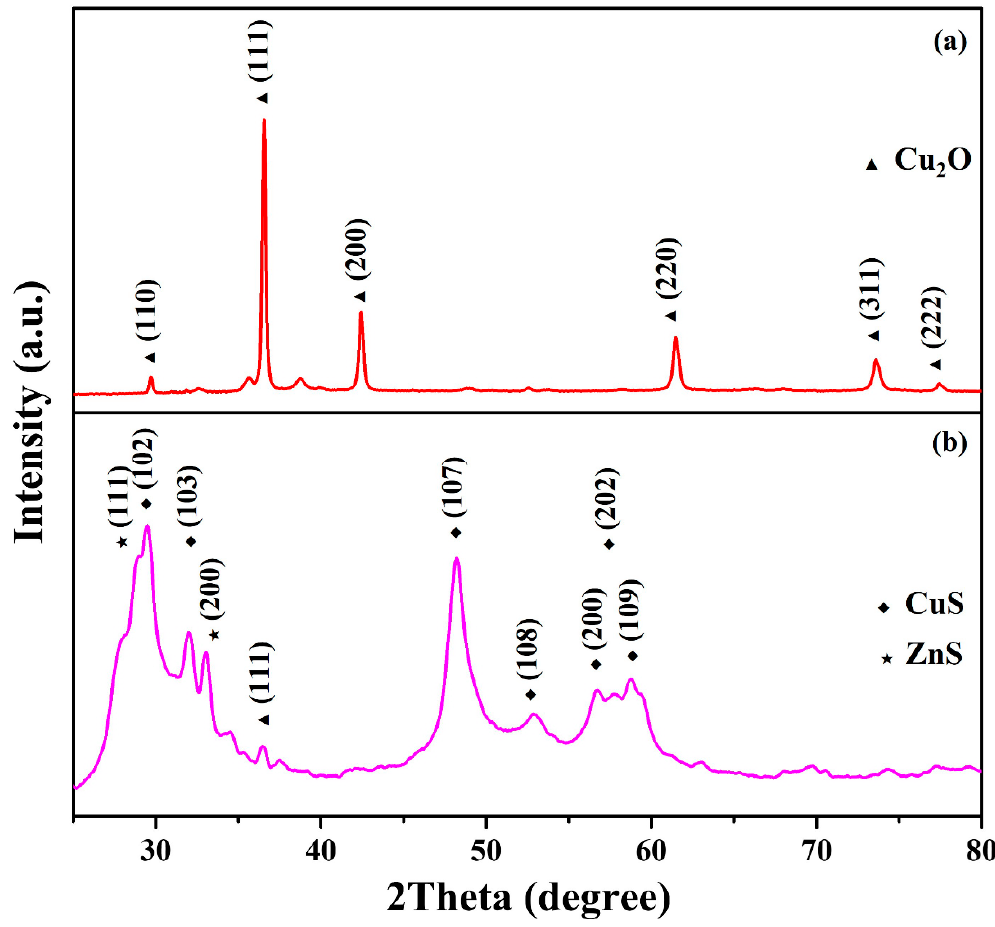
Figure 1. The XRD spectra of ( a ) Cu 2 O nanostructures and ( b ) the Cu 2 O/CuS/ZnS nanocomposite grown at the 10 mM ZnS precursor and 20 min reaction time.